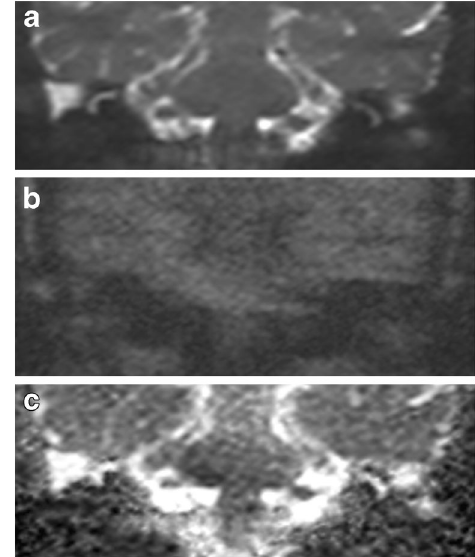
Fig. 2 Typical DWI appearance of non-cholesteatomatous soft tissue. Coronal images through the right post-operative mastoid remnant shows the soft tissue ( white arrow ) as high signal on a the b0 image, but loses signal on b the b1000 image, and hence demonstrates high signal on c the ADC map. Surgery confirms granulation tissue